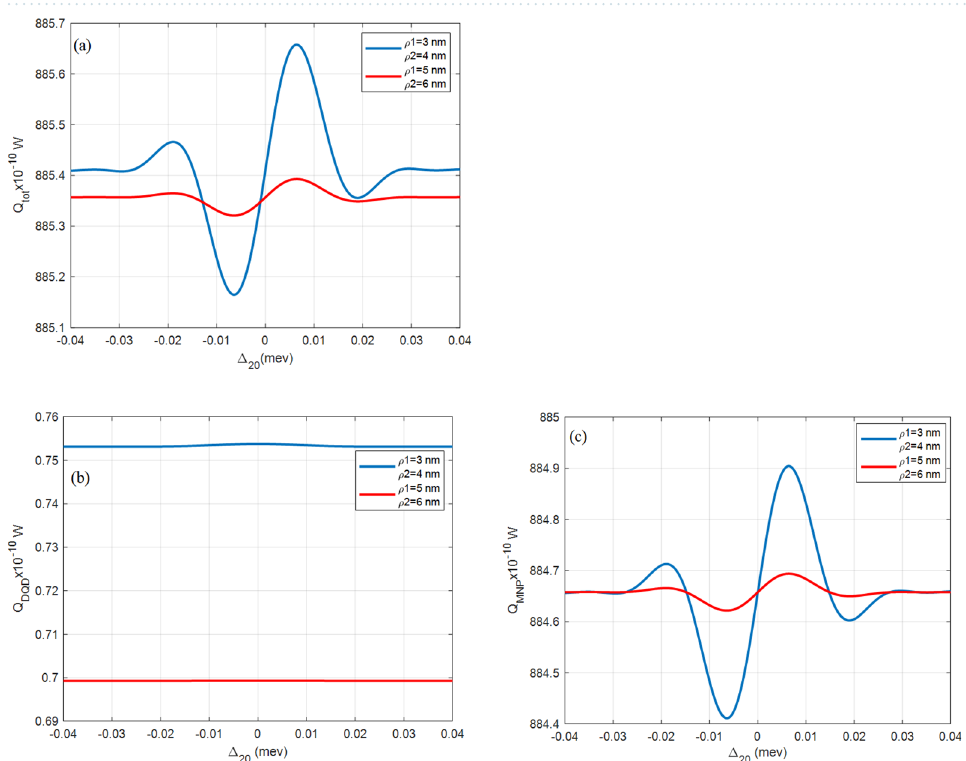
Figure 7. ( a ) The total ( Q tot ) , ( b ) DQD ( Q DQD ), and ( c ) MNP ( Q MNP ) absorption rates from the DQD- MNP hybrid system at R = 20nm and a = 10nm for different QD sizes as in the inset and (cid:31) 0 02 = 0.09meV , � 0 13 = 1.8GeV, T 01 = 30 γ 0 , T 32 = 8 γ 0